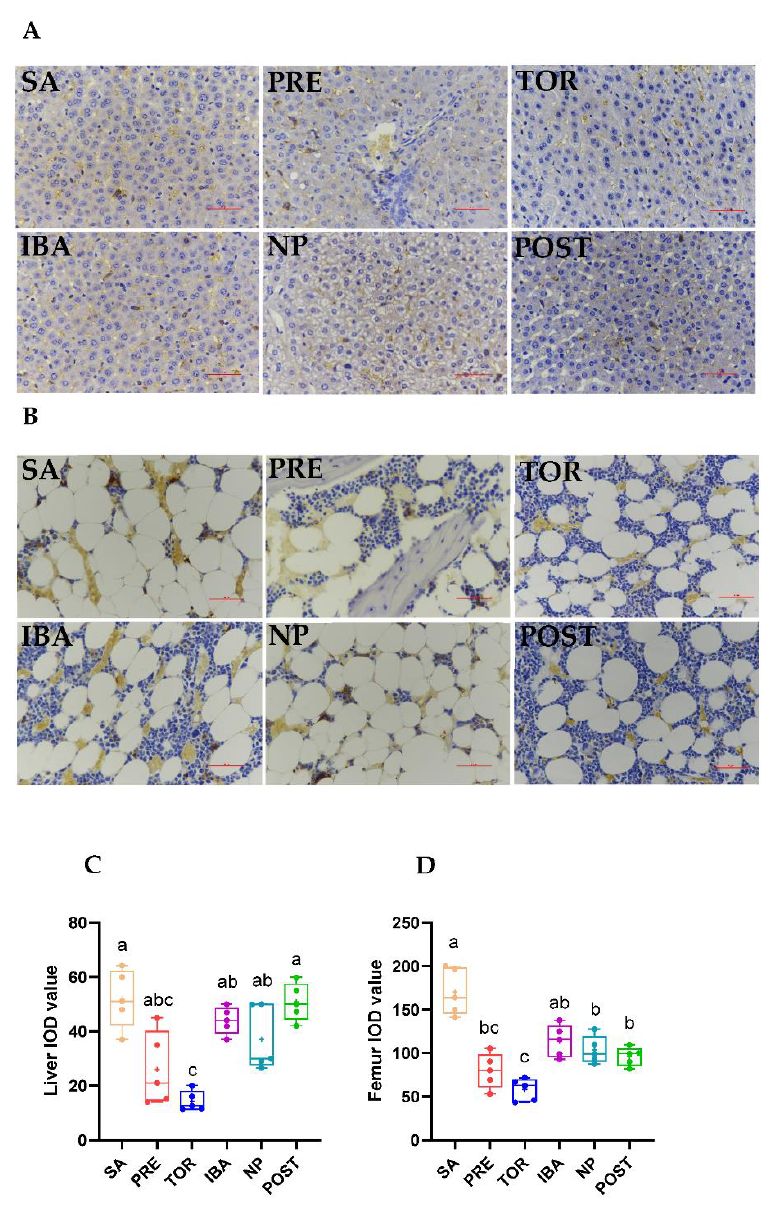
Figure 6. Differences in iron distribution in liver and femur of Daurian ground squirrels in different groups. Histological analysis of iron deposits in liver ( A , Bar = 50 μm) and femur ( B , Bar = 50 μm, represents the actual length of the image) sections by DAB-Prussian iron staining. ( C , D ) Integrated optical density (IOD) of iron-positive particles in liver and femur, respectively. SA, summer active group; PRE, pre-hibernation group; TOR, torpor group; IBA, interbout arousal group; NP, near post-hibernation group; and POST, post-hibernation group. Boxes represent upper and lower quartiles, middle horizontal line represents median, plus sign represents average, lines extending from upper and lower ends represent upper and lower edges, respectively, and points represent individual sample values ( n = 5). Superscripts with different letters indicate significant differences ( p < 0.05) among groups by Sidak test. Superscripts with same letters denote no significant differences ( p > 0.05).